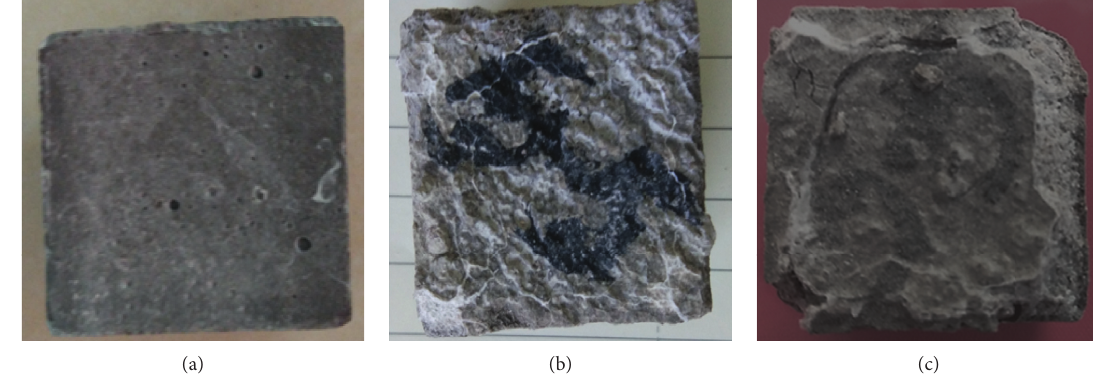
Figure 14: Appearance of corroded concrete specimens exposed to sulfate ions in the laboratory. (a) 6 months. (b) 9 months. (c) 11 months.